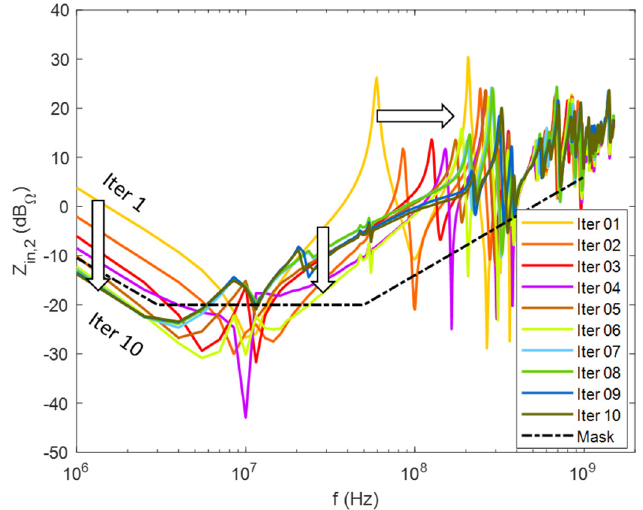
Figure 12. Measured input impedances (after de-embedding) at port P 2 for iteration 1 (1 mounted decap) to iteration 10 (10 mounted decaps).